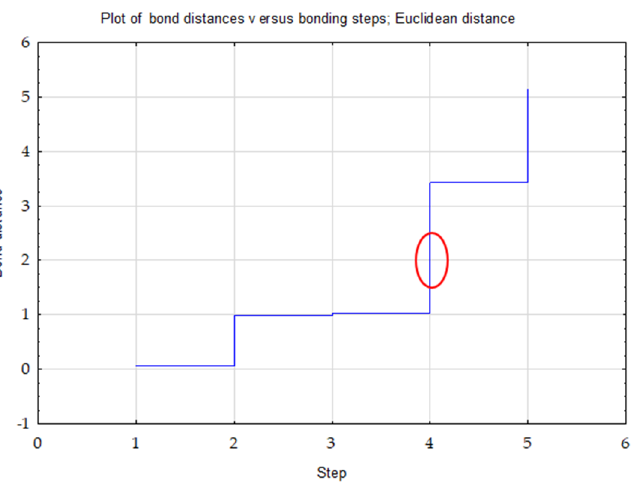
Figure 1. Graph of changes in bond distances in successive agglomeration steps for TOC, Nt and C/N.